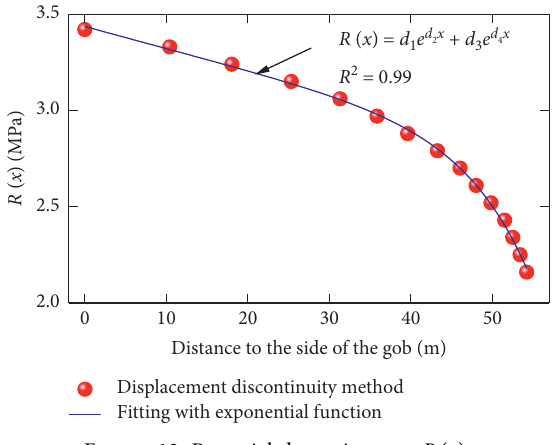
Figure 12: Potential dynamic stress R ( x ). Table 4: Parameters used in the mathematical models.